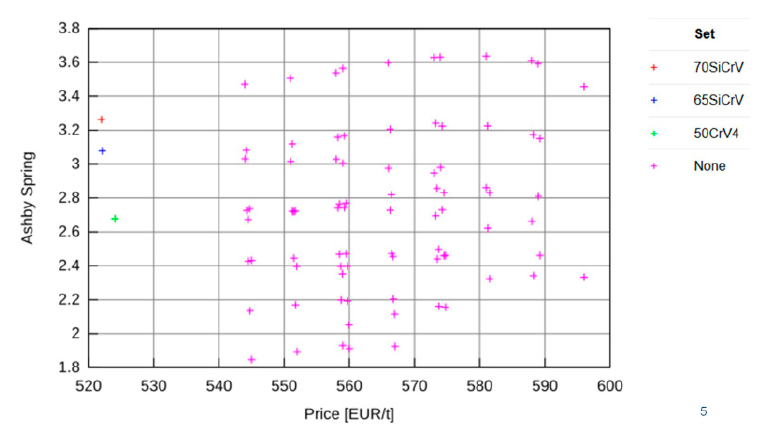
Figure 1. Modification of nickel and chromium-free alloys as a function of the Ashby coefficient to material cost [22].